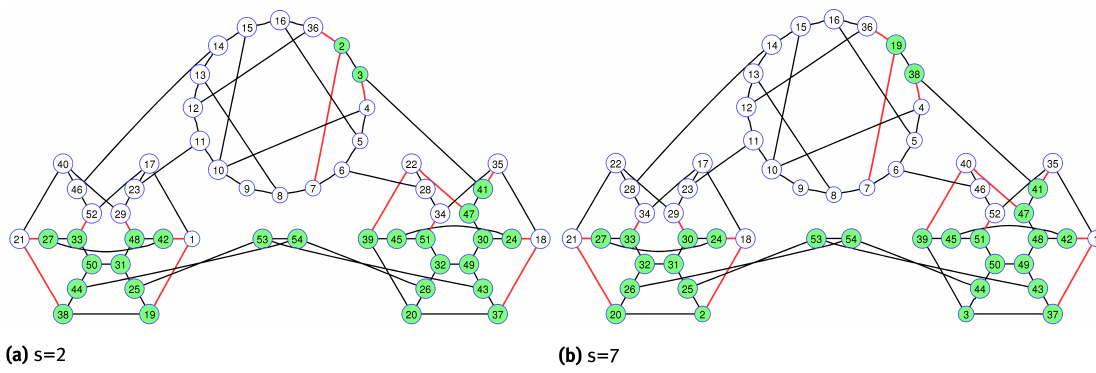
Figure 6: Ellingham-Horton 54-graph. Shown is the result of the spectral bisection method described in Section 4 using the 10 permutations π 0 , . . . , π 9 to create L p as defined in (3.19). The resulting partitions shown are V 1 (colored vertices), V 2 (non- ( V 1 , V 2 ) | = 15 , D ( V 1 ) = colored vertices) and the partition boundary (red edges) at times s = 2 and s = 7 . (a) π (2) ( G ) : | C π (2) π (2) 81 , D ( V 2 ) = 81 . (b) π (7) ( G ) : | C ( V 1 , V 2 ) | = 15 , D ( V 1 ) = 54 , D ( V 2 ) = 81 . π (2) π (7) π (7) π (7)